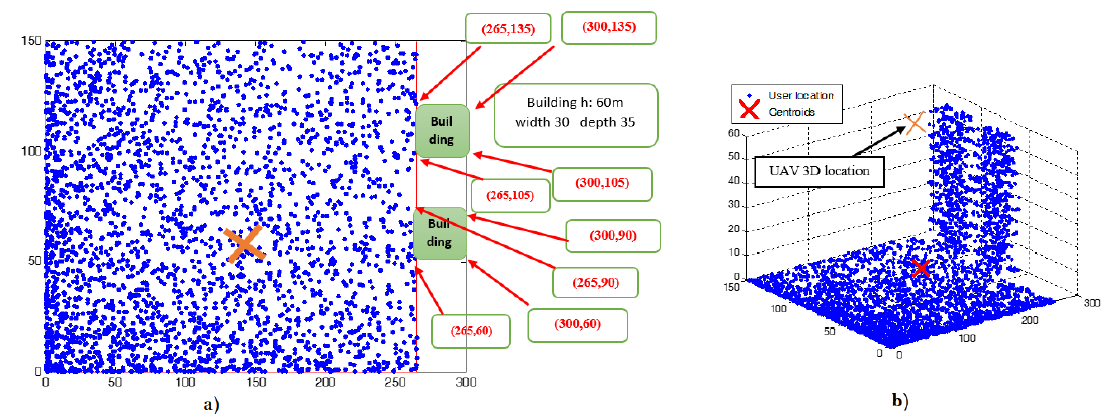
Figure 2. ( a ) Top view of the receivers’ distribution and the two buildings’ locations; ( b ) 3D view of outdoor and indoor receivers.